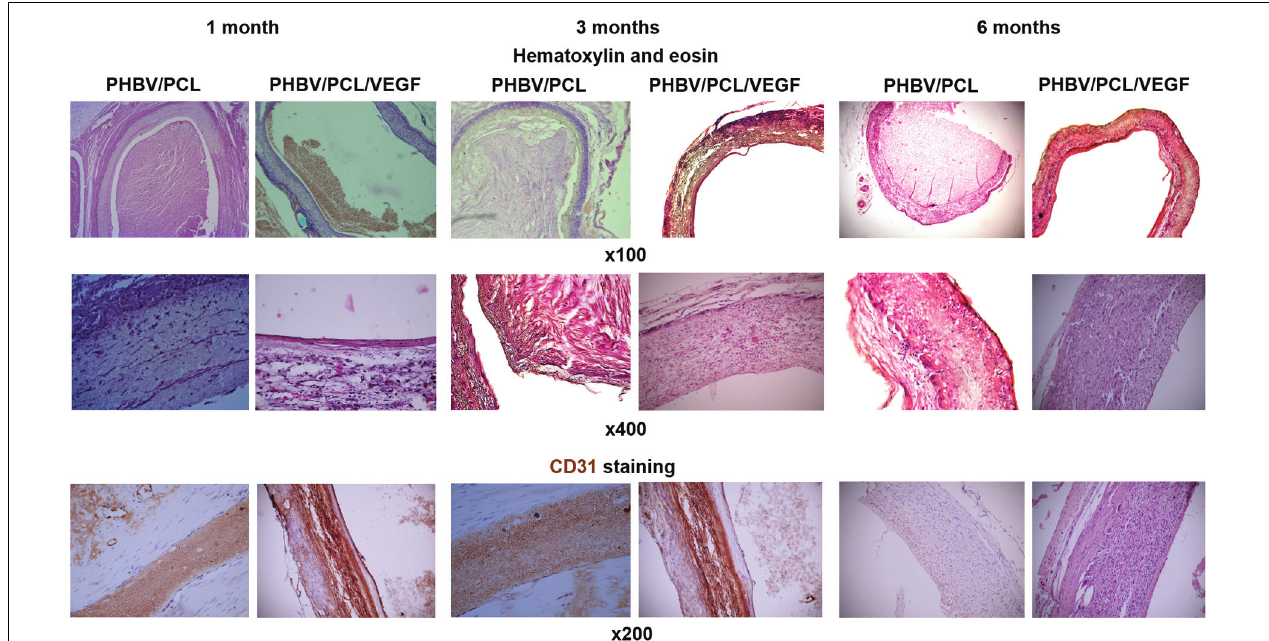
FIGURE 3 | In vivo performance of PHBV/PCL vascular grafts with and without VEGF: histological and immunohistochemical examination. PHBV/PCL grafts with VEGF were completely patent whereas those without were occluded. Hematoxylin and eosin staining revealed a putative endothelial cell monolayer in certain parts of the inner surface of PHBV/PCL grafts with VEGF even 1 month postimplantation and almost entire inner surface 3 and 6 months postimplantation. This was confirmed by CD31 staining but was not the case for PHBV/PCL grafts without VEGF. CD31-positive cells are stained brown.